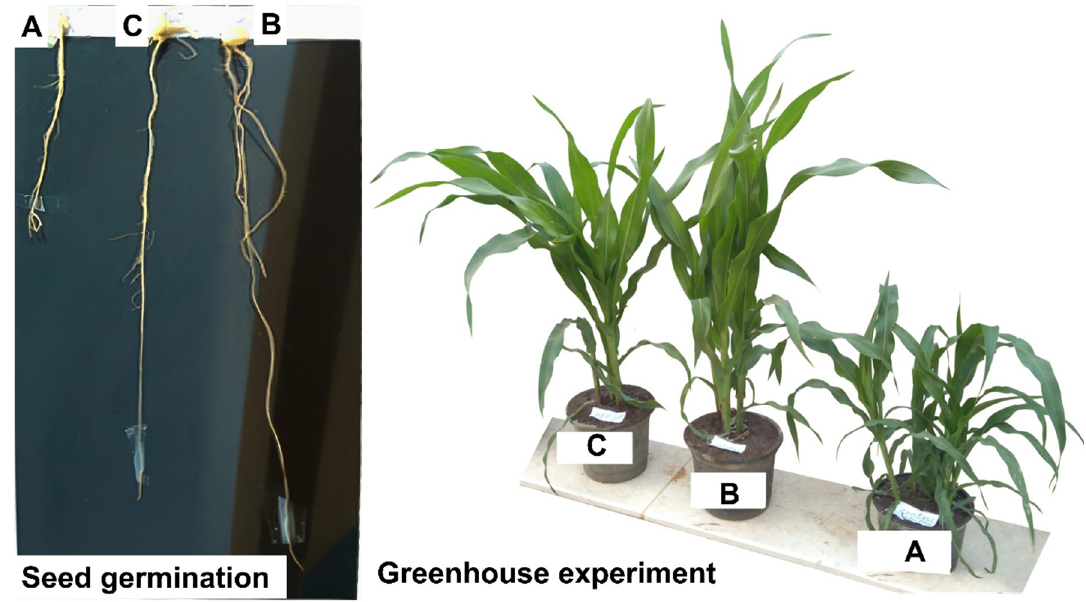
Figure 8. Toxicity assessment of pyrethroid insecticide cypermethrin before and after bacterial degradation compared with distilled H 2 O on Zea mays plant. Panel ( A ) cypermethrin before bacterial degradation; panel ( B ) distilled H 2 O; ( C ), biodegradable products of cypermethrin after bacterial degradation.